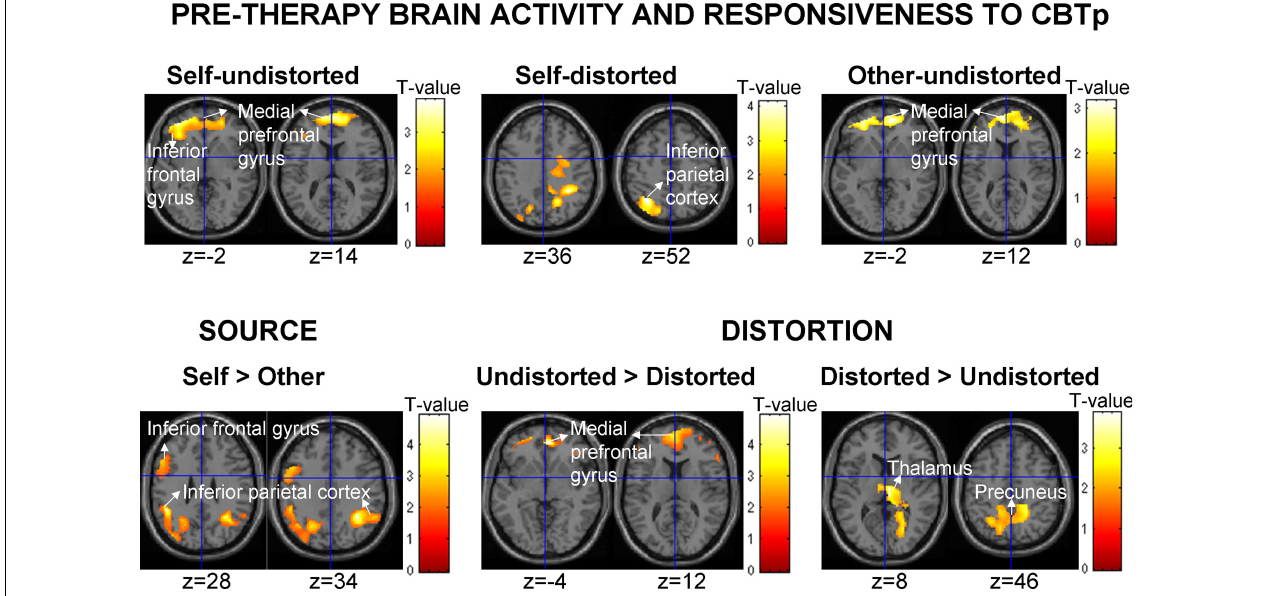
FIGURE 2 | Pre-therapy brain activity associated positively with a response to CBTp (reduction in total PANSS symptoms) in patients with associated MNI z co-ordinates (maps thresholded at p = 0.05 uncorrected). Left hemisphere is shown on the left.